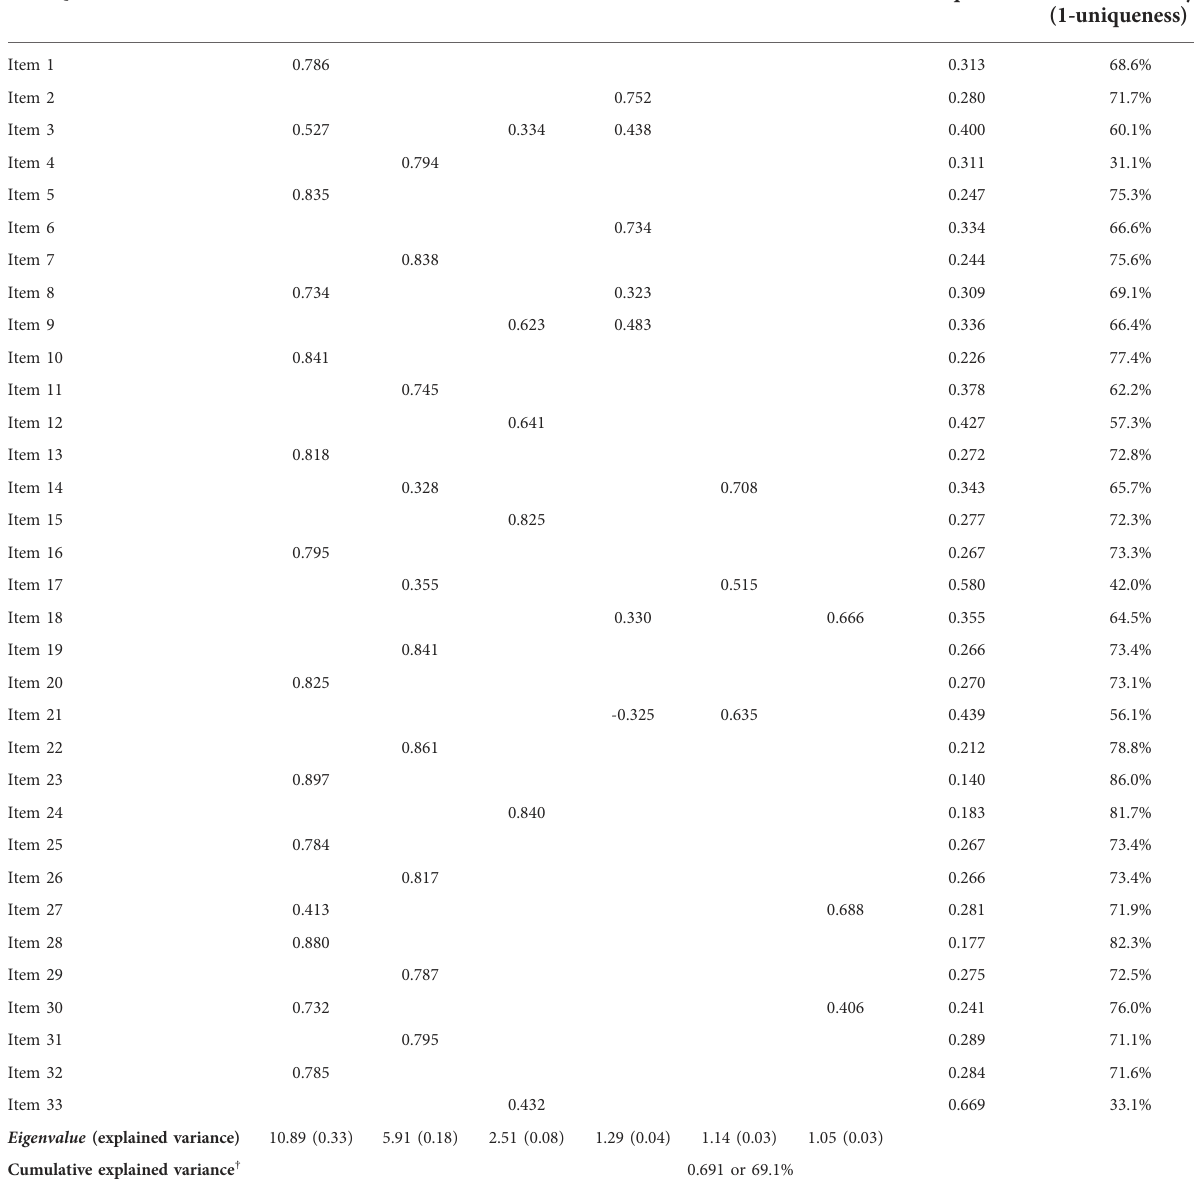
Table 3 Validity analysis (exploratory factor analysis) of the Dutch Eating Behavior Questionnaire (DEBQ). DEBQ